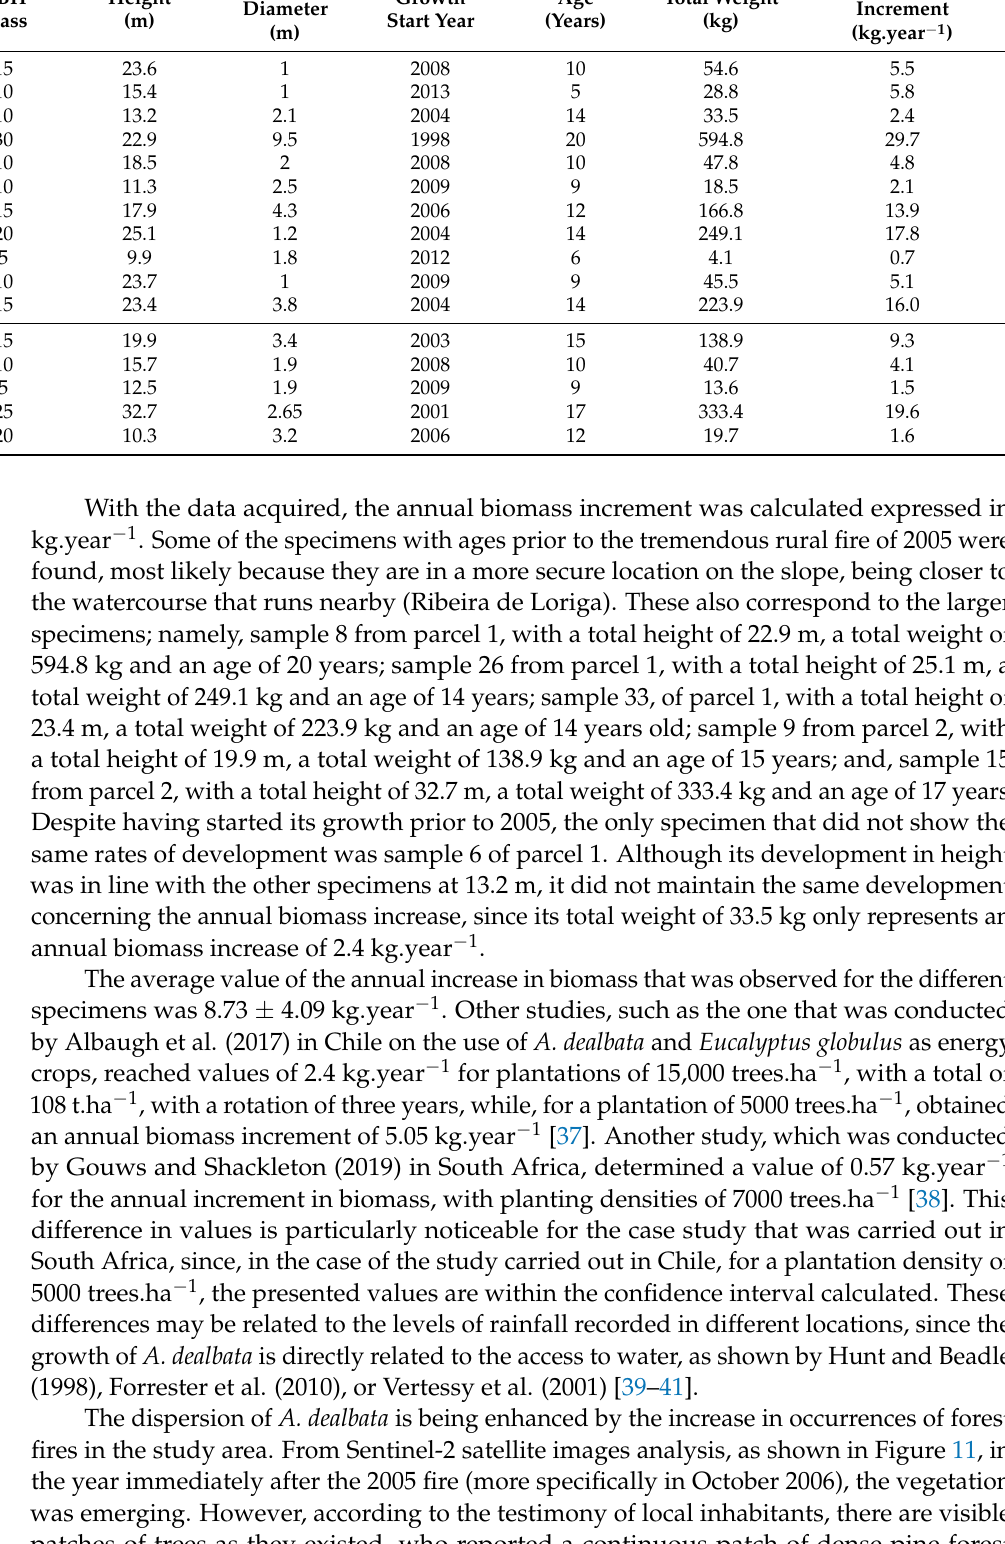
Table 1. Measurements and annual biomass increment calculated for the samples collected in Casal do Rei. Parcel